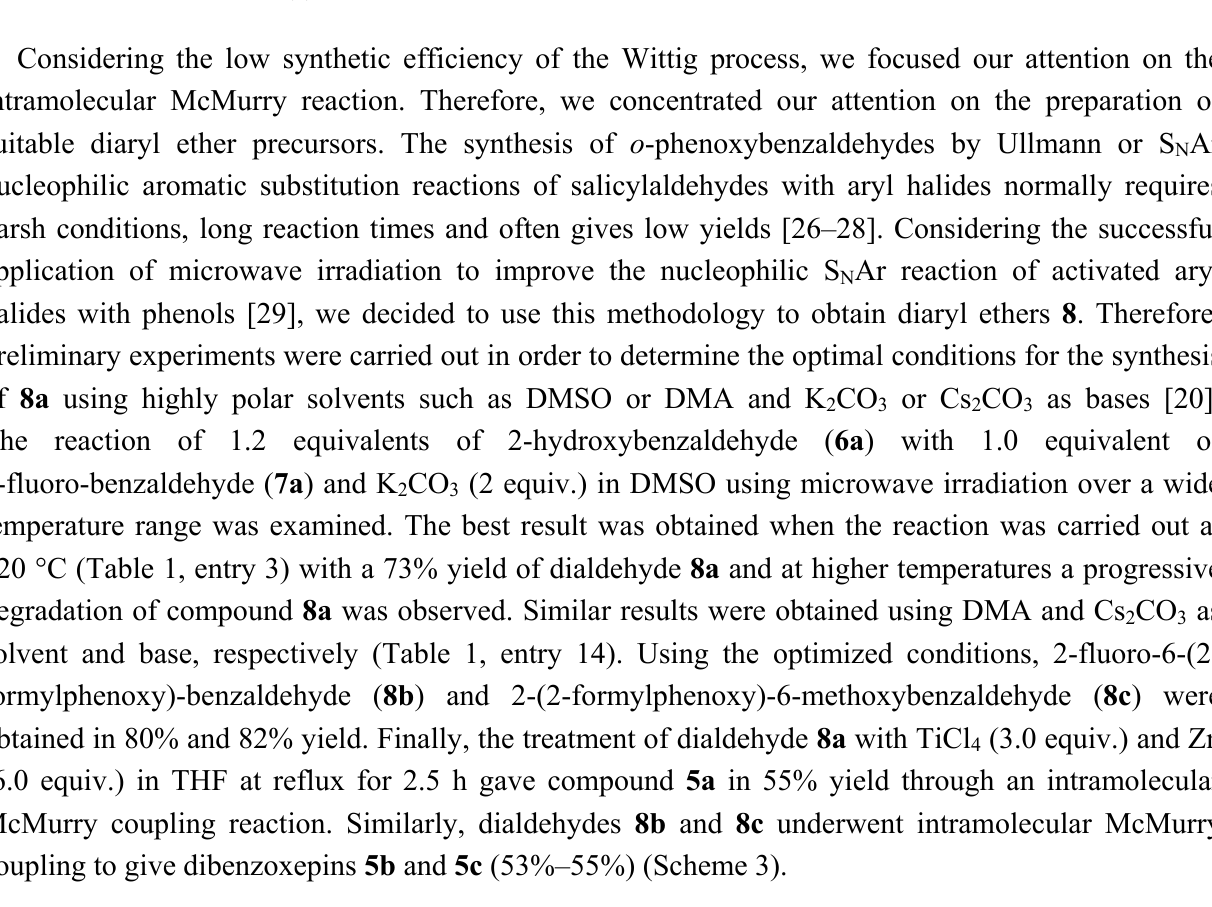
Reagents and conditions : (a) t -BuOK, THF, 0 °C, 30 min; (b) 2 , THF, 18 h, rt; (c)